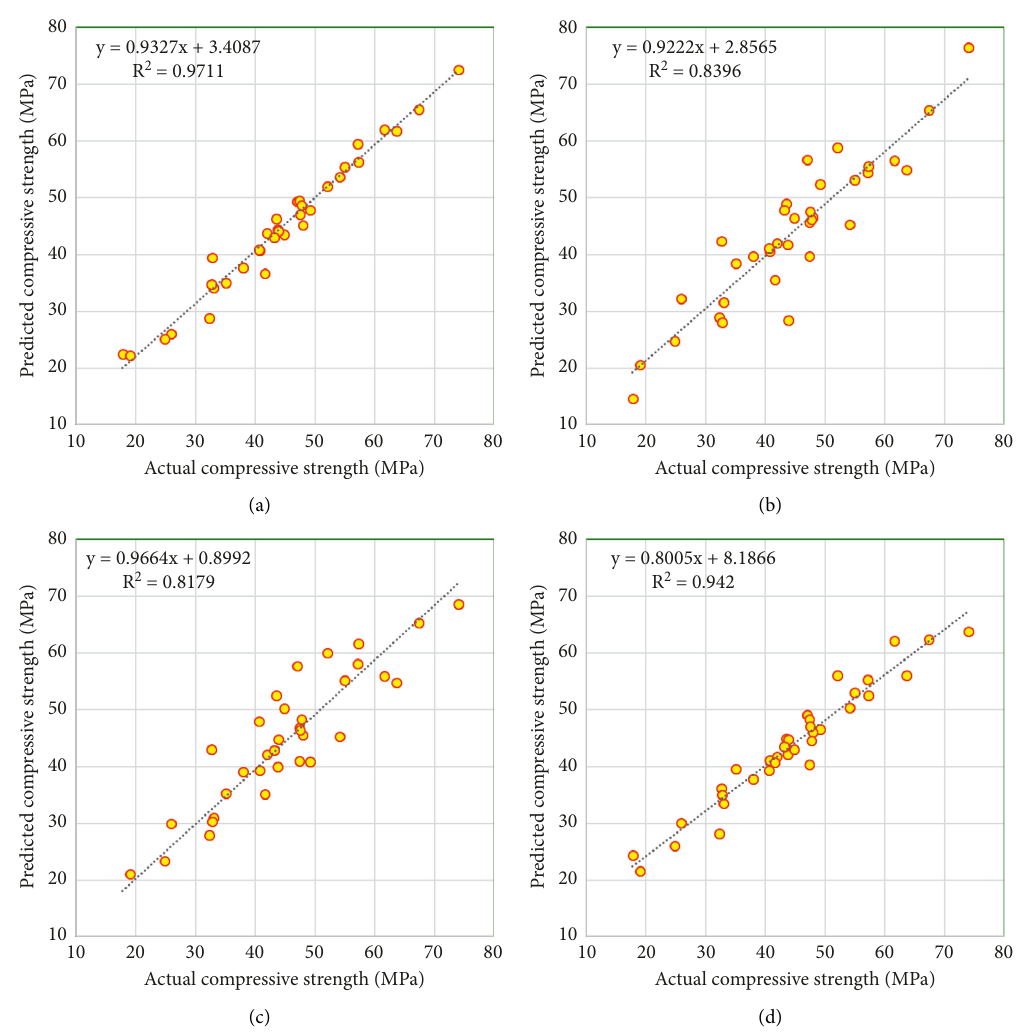
Figure 10: Scatter plot presentation using the developed AI model and for (90%-10%) data division scenario. (a) DLNN model. (b) MARS model. (c) ELM model. (d) RF